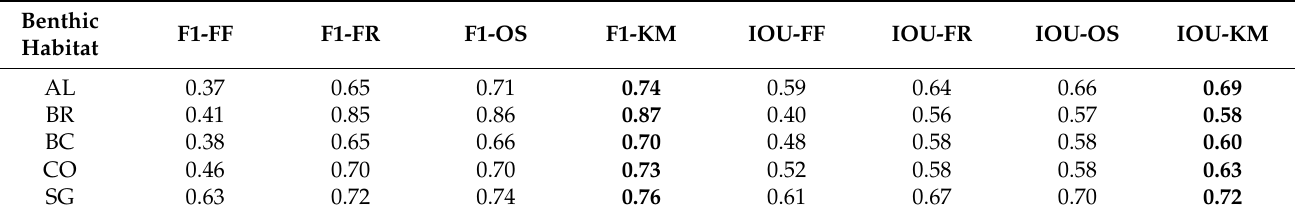
Table 1. The average F1-Score and IOU results of the proposed algorithms on the tested highly illuminated and low contrast benthic habitat images.